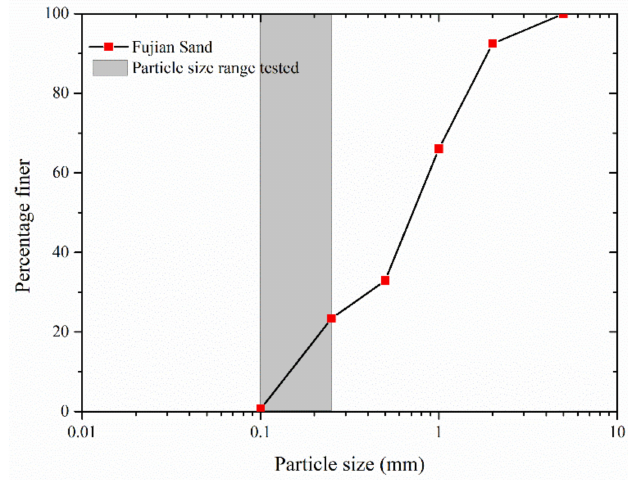
Figure 1. Grain size distributions of the Fujian sand.